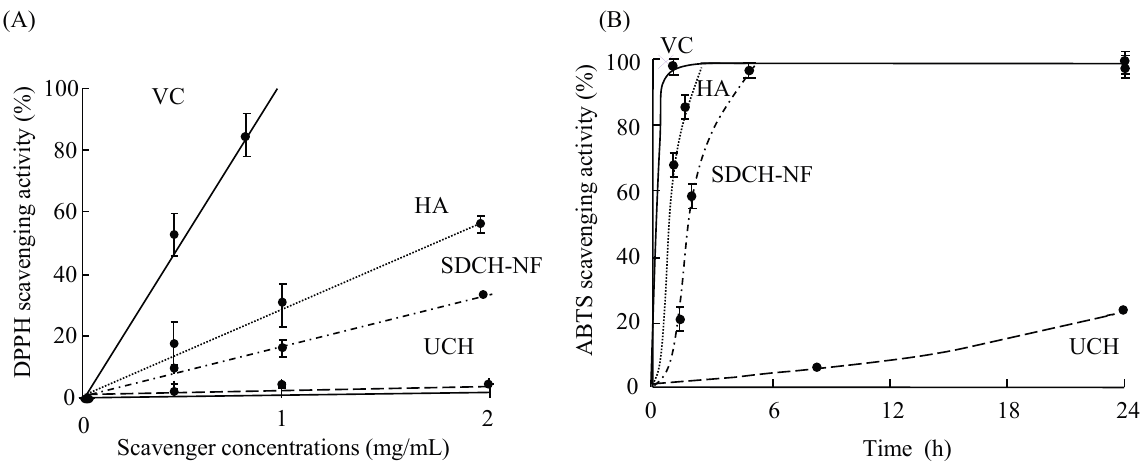
Figure 1. Relative effectiveness of different concentrations of the antioxidants in reducing 1,1 ′ -diphenyl-2-picrylhydrazyl (DPPH) radicals ( A ) and the time course for the